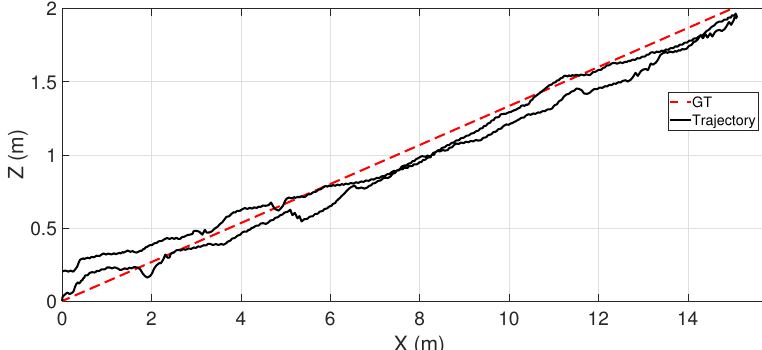
Figure 9. Trajectory in the xz plane for test 1.